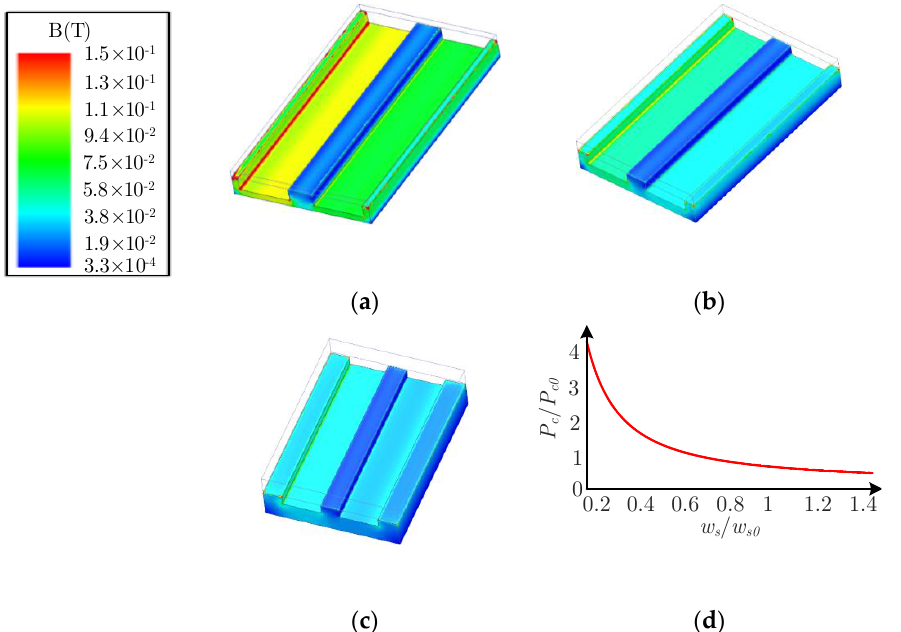
Figure 9. Distribution of magnetic flux density with different w s : ( a ) w s = 52.6 mm; ( b ) w s =5.2 mm; ( c ) w s = 10.4 mm; ( d ) core loss with w s .